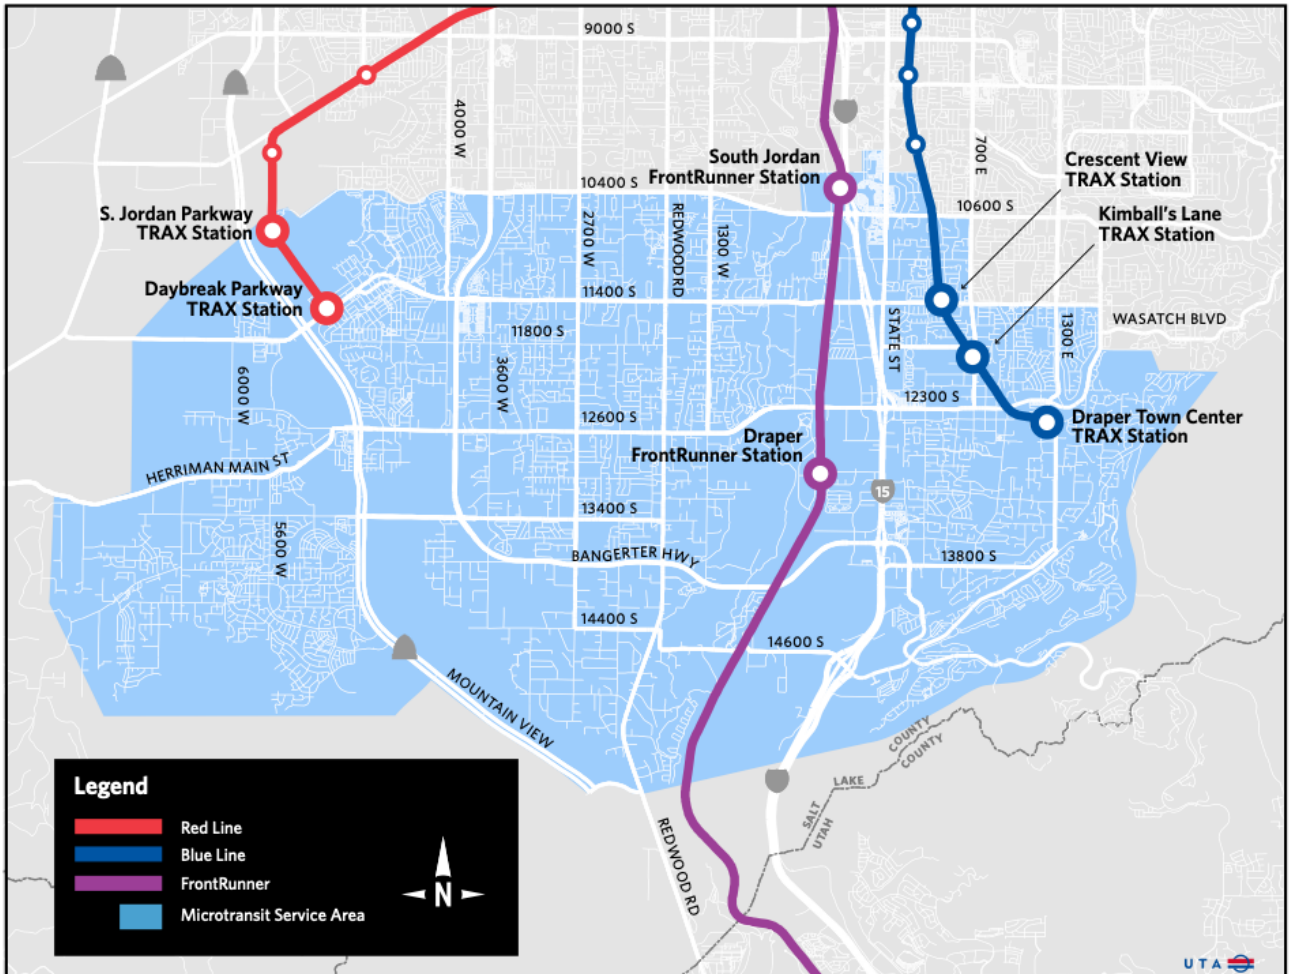
Figure 1. Utah Transit Authority (UTA) on-demand microtransit service area. Image courtesy